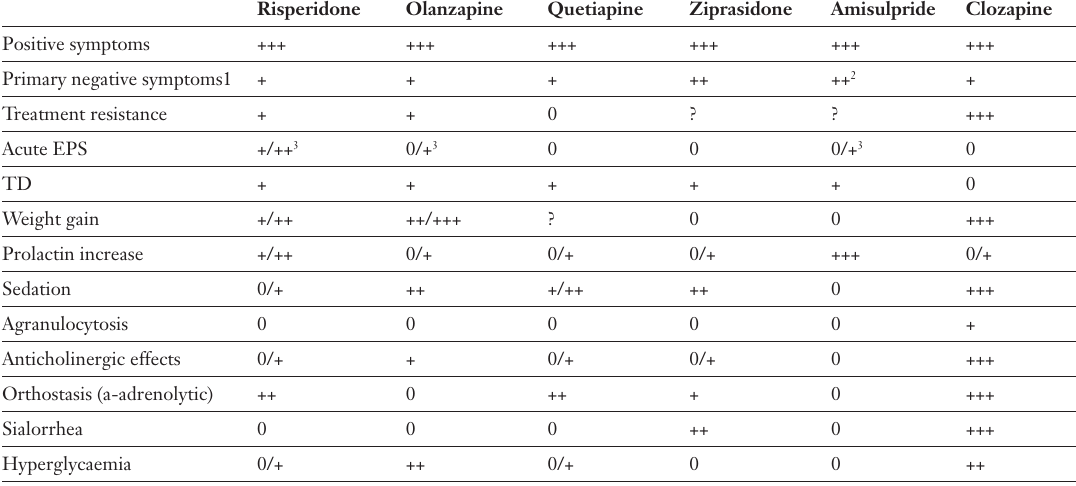
Table 3 Clinical characteris- tics and side effects of atypical antipsy-